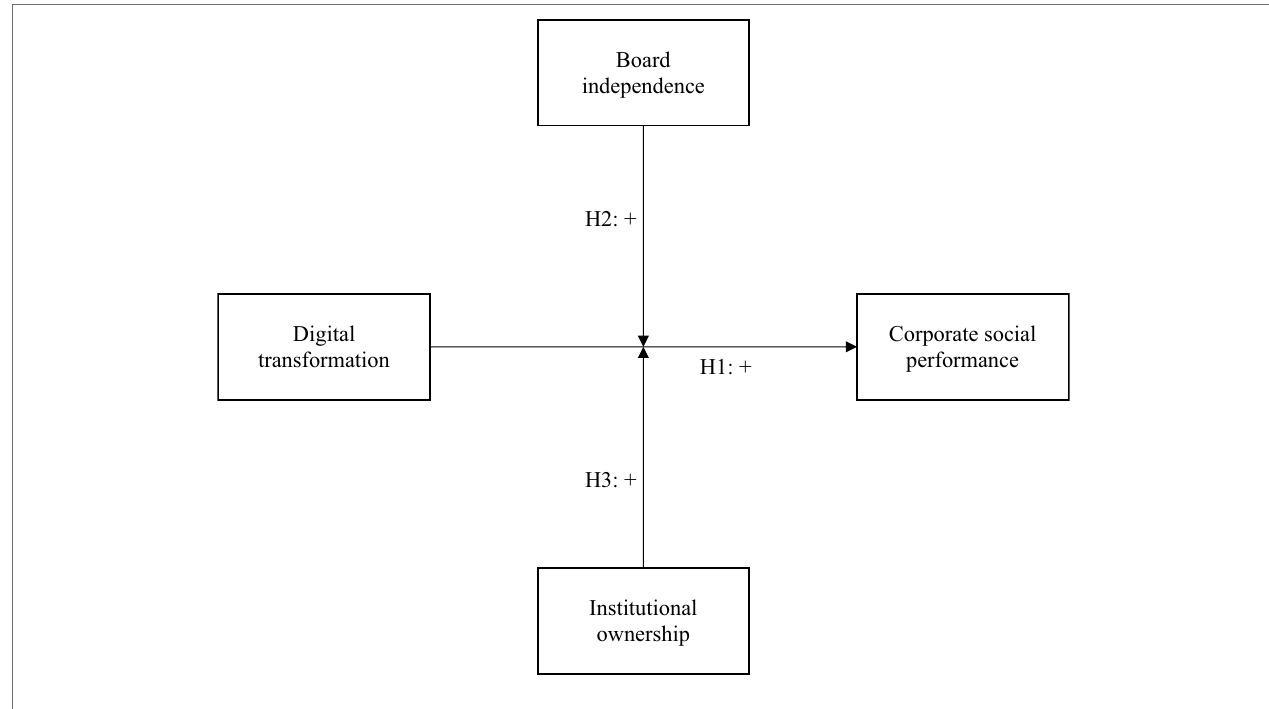
FIGURE 1 | Conceptual